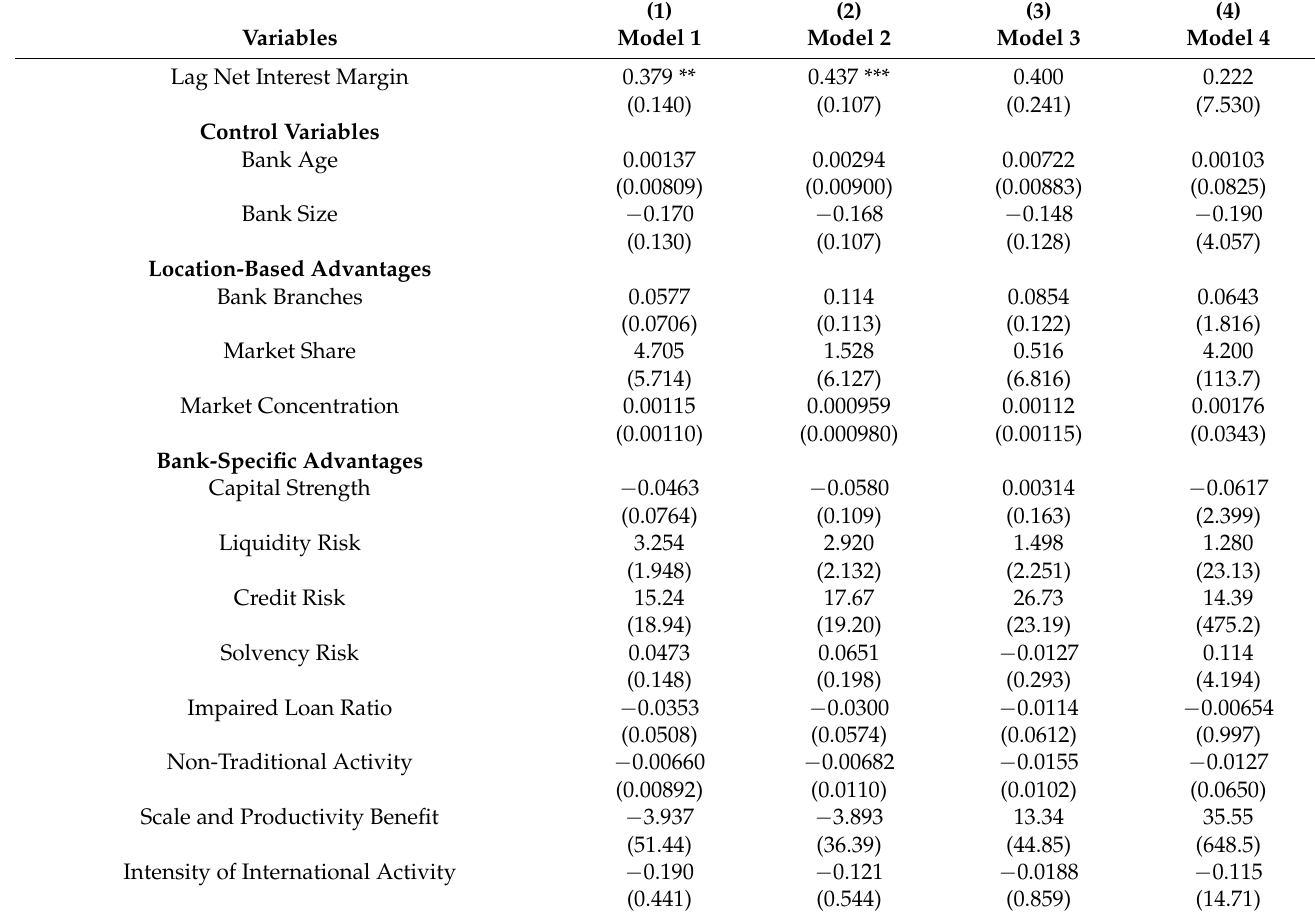
Table 12. Model of comparing dynamic cost of foreign liability with firm-specific advantages (H4) in period: